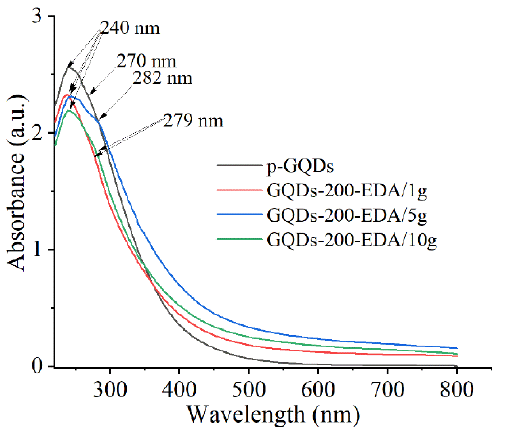
Figure 7. UV-Vis spectra of p-GQDs, GQDs-EDA/1 g, GQDs-EDA/5 g, and GQDs-EDA/10 g.